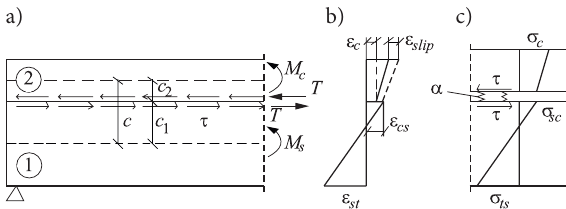
Fig. 3. Calculation schemes for the distribution of efforts (a), deformations (b) and stresses (c), and connection stiffness between concrete and metal (